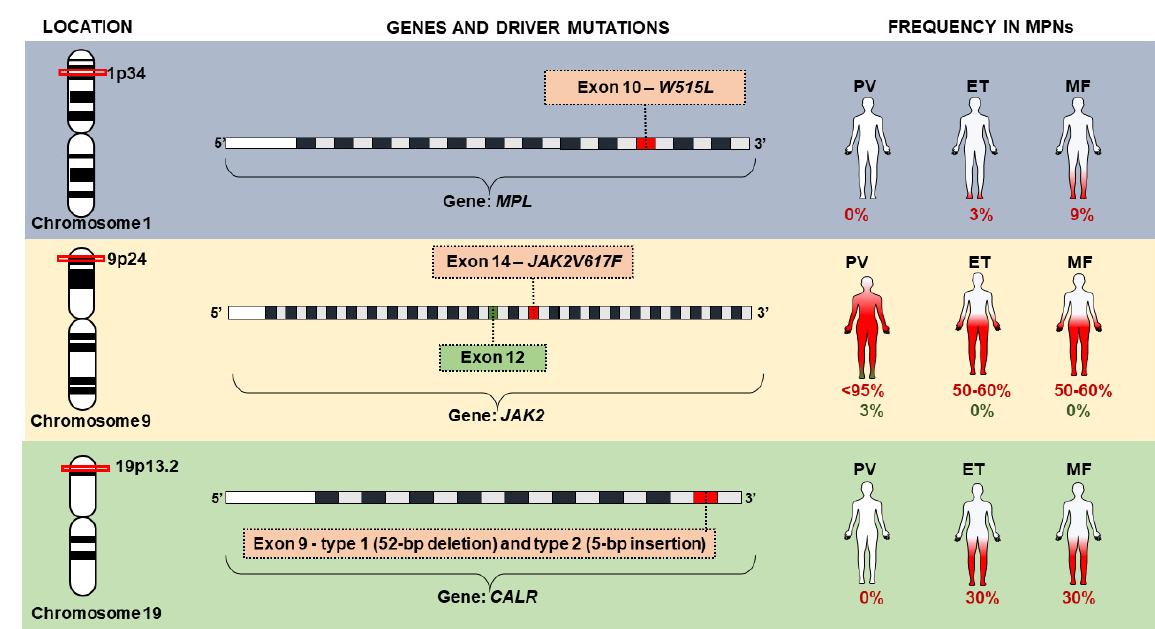
Figure 2. Driver mutations in JAK2 , MPL and CALR genes associated with chronic myeloproliferative neoplasms (MPNs).